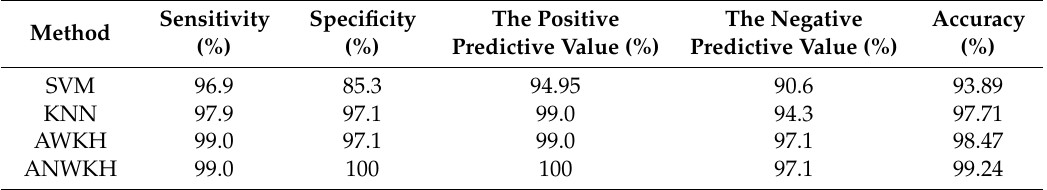
Table 3. Cross-verification classification results of the test set for ANWKH, AWKH, HKNN, and SVM.